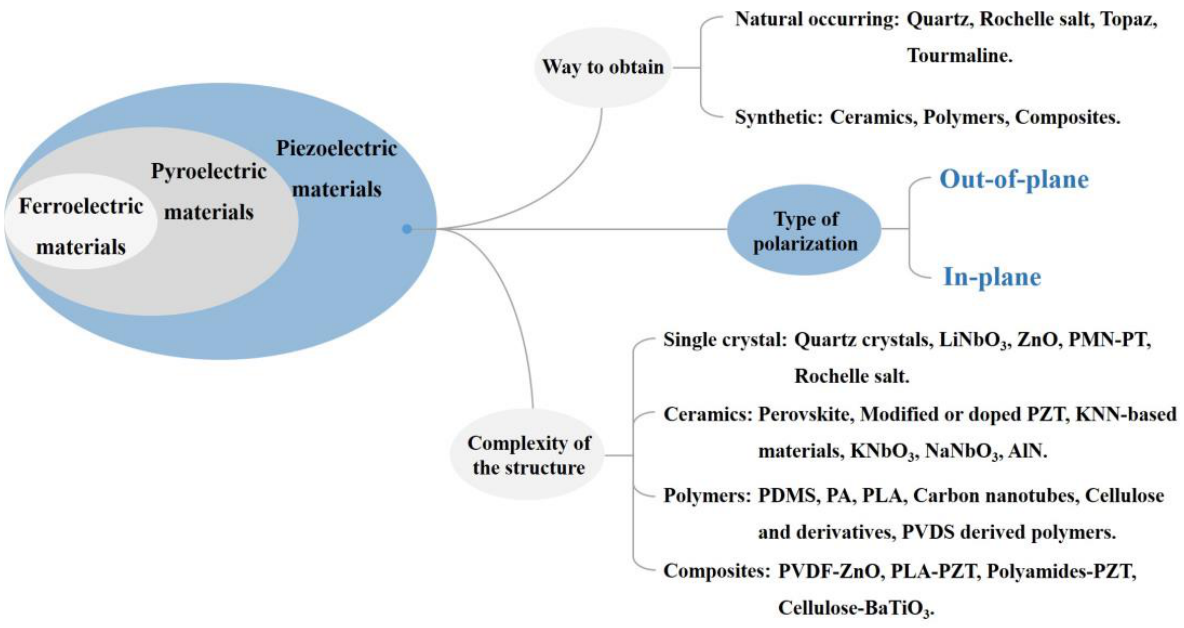
Figure 1. The relationship between piezoelectric materials, pyroelectric materials and ferroelectric materials. Piezoelectric materials are classified according to three different criteria.